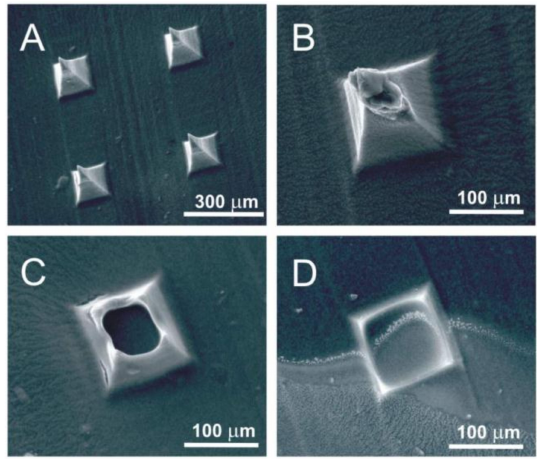
Figure 3. Progressive dissolution ( A – D ) of a 200 × 200 × 350 micron MN upon exposure to a pH 8 Britton Robinson buffer (( A ) 0 min, ( B ) 5 min, ( C ) 10 min, ( D ) 15